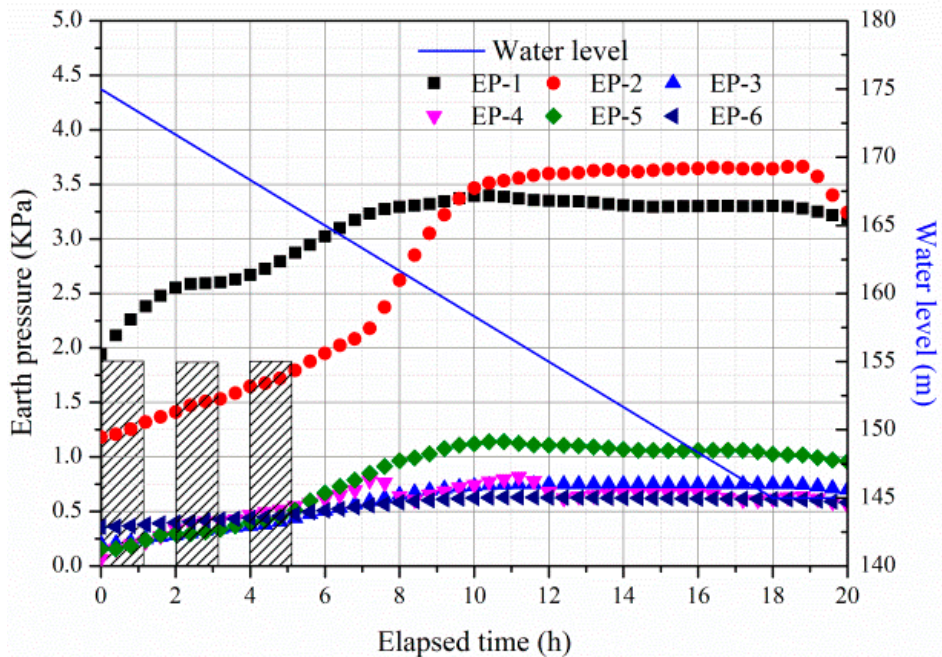
Figure 16. Soil pressure levels recorded during the water lowering process and rainfall simulations.